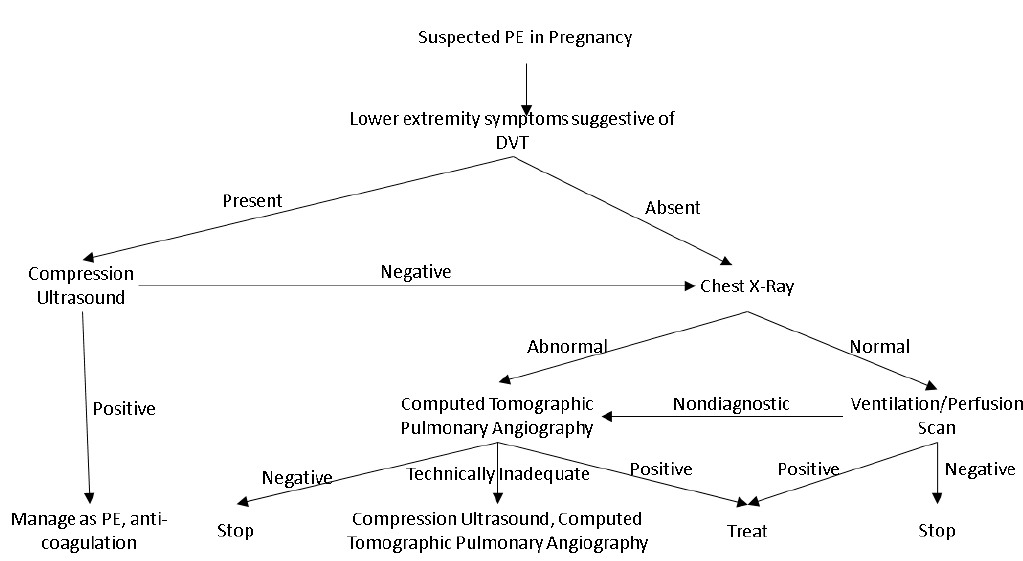
Figure 3. Diagnostic algorithm for evaluation of suspected PE during pregnancy.